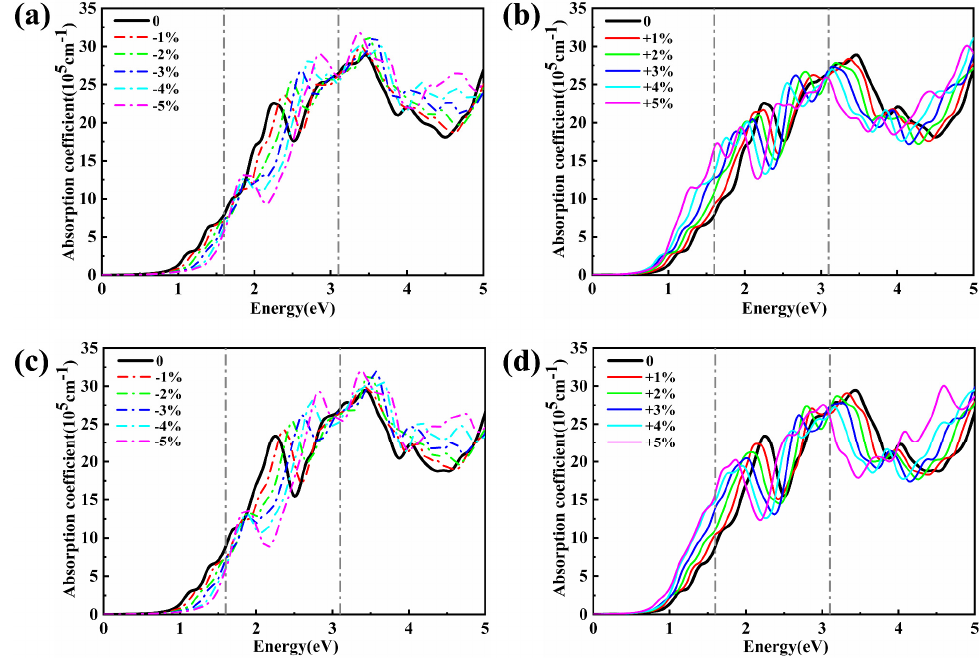
Figure 6. Optical absorption spectrum of ( a , b ) Te 4 –MoSTe/MoGe 2 N 4 vdWH and ( c , d ) S 4 – MoSTe/MoGe 2 N 4 vdWH under biaxial strain. Negative and positive values represent compressive stress and tensile stress, respectively. The variations of the band gaps with different interlayer distances for Te 4 - MoSTe/MoGe 2 N 4 and S 4 -MoSTe/MoGe 2 N 4 vdWH are shown in Figure 7, where the equi- librium interlayer distances are 3.4 Å and 3.1Å, respectively. We find that there is no band gap in Te 4 -MoSTe/MoGe 2 N 4 vdWH when the interlayer distance is less than 3.63 Å. When the interlayer distance is larger than 3.63 Å, the band gap of Te 4 -MoSTe/MoGe 2 N 4 vdWH increases with an increase in the interlayer distance. The Te 4 -MoSTe/MoGe 2 N 4 vdWH changes between semimetal and indirect band gap semiconductors when the interlayer distance changes. The weight band structures of Te 4 -MoSTe/MoGe 2 N 4 and S 4 - MoSTe/MoGe 2 N 4 vdWH at different interlayer distances are depicted in Figure S4. We find that the band gap in S 4 -MoSTe/MoGe 2 N 4 vdWH increases with an increasing inter- layer distance and decreases with a decreasing interlayer distance. When the interlayer distance is less than 2.3 Å, the band gap of the S 4 -MoSTe/ MoGe 2 N 4 vdWH becomes small and close to zero. The results indicate that changing the interlayer distance can also regu- late the electronic structure of the MoSTe/MoGe 2 N 4 vdWH.